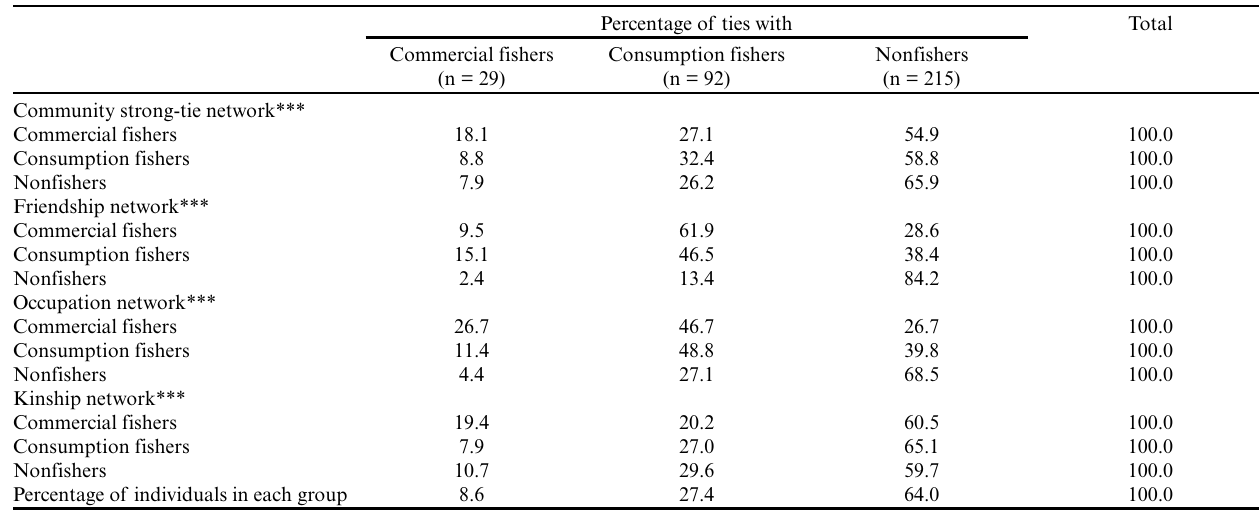
Table 6 . Frequency distribution (%) of strong ties within and between fisher and nonfisher groups. χ ² p: ***p <